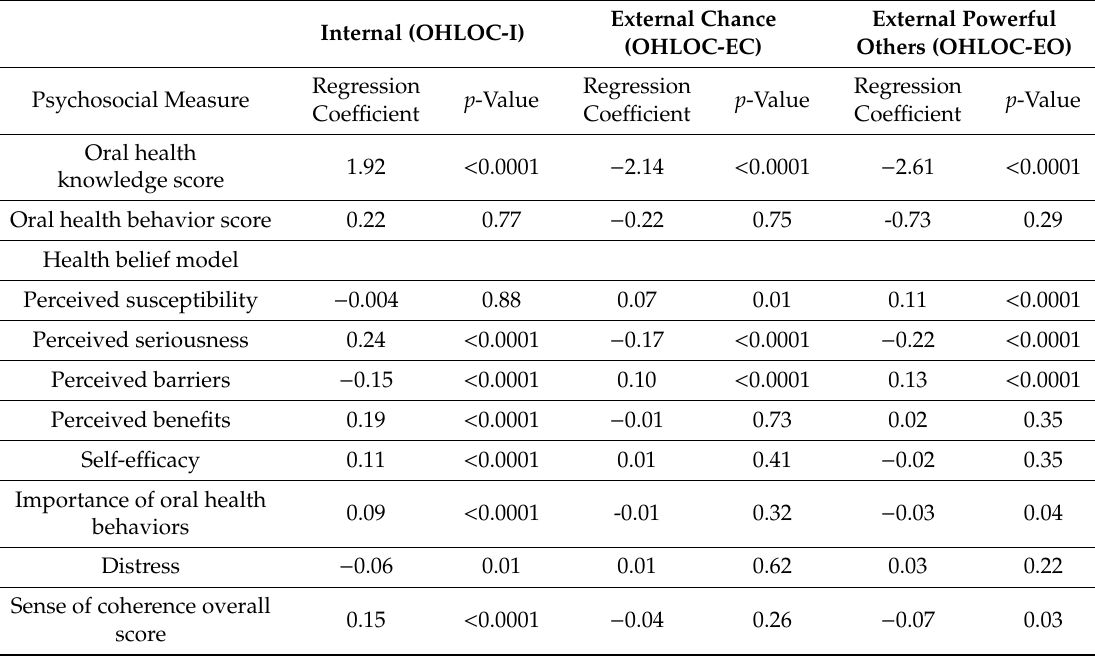
Table 4. Convergent validity—association between OHLOC subscales and other psychosocial measures (N range = 978–1000).